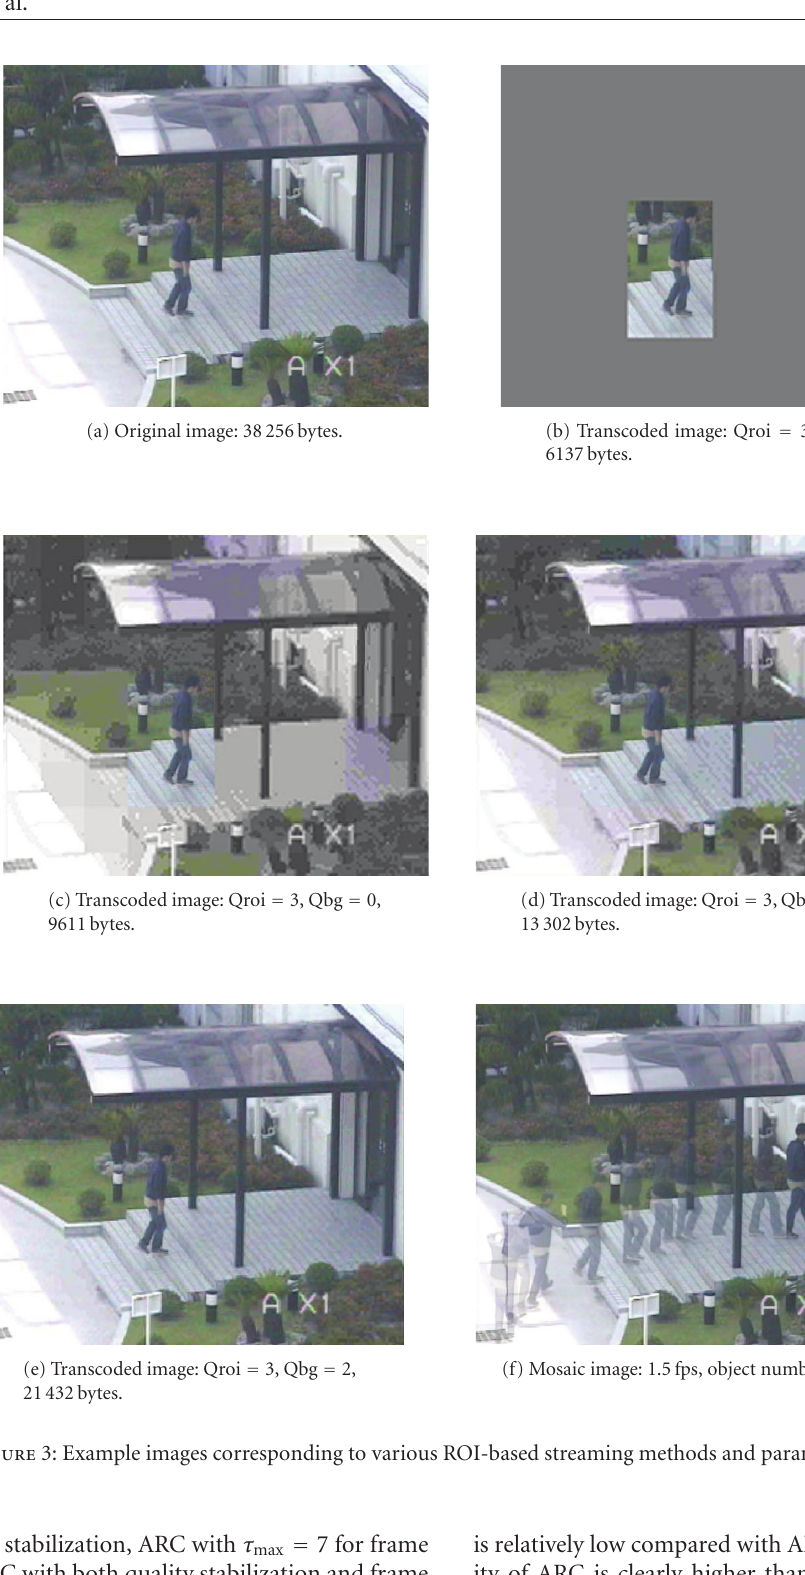
= 7 for frame max